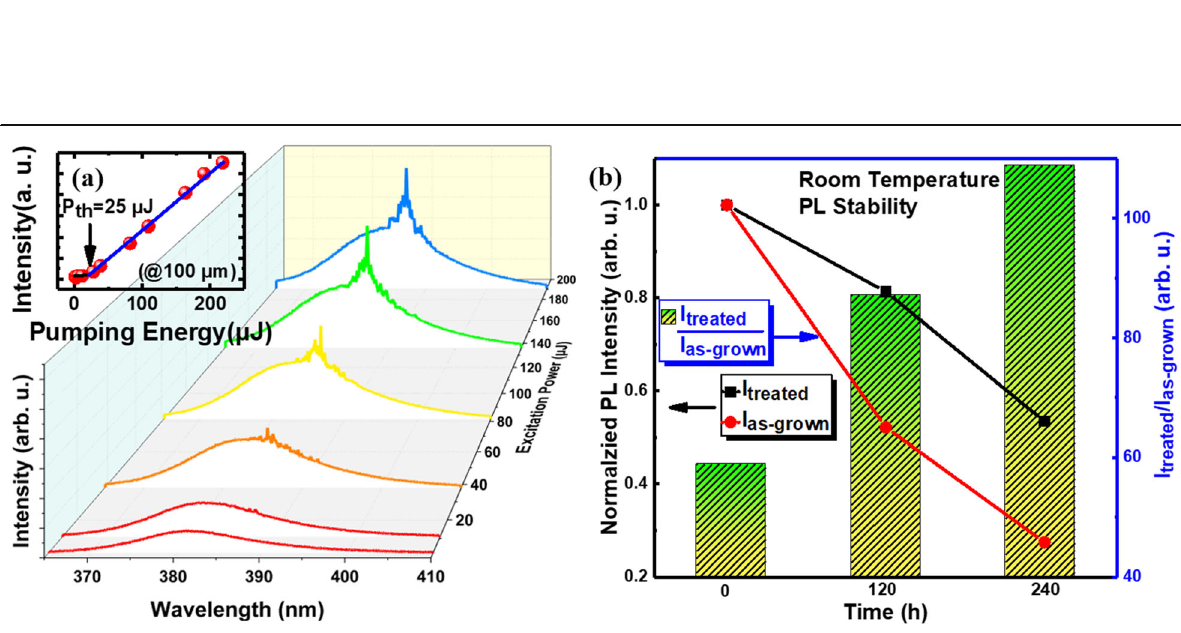
Fig. 5 a Lasing under optical pumping from ZnO NWs irradiated by 200 W Ar plasma. b Stability of ZnO NWs (the intensity ratio after plasma treatment over time compared with the as-grown